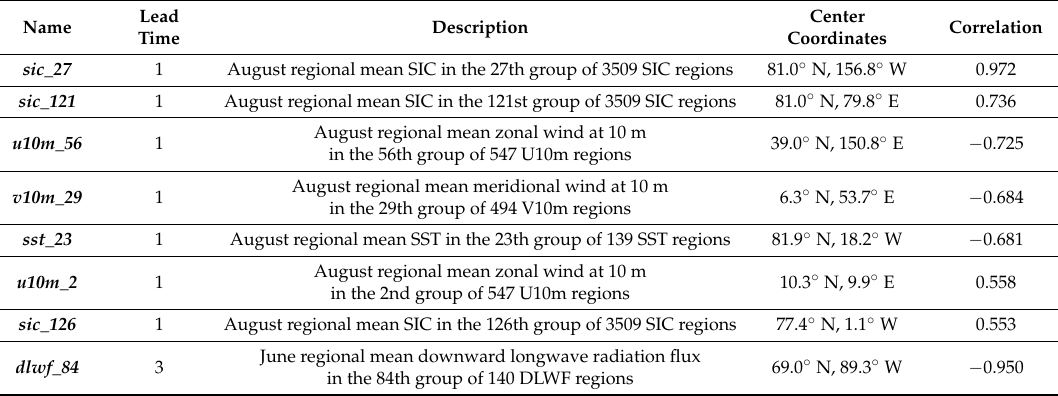
Table 2. Precursors associated with September Arctic SIE.